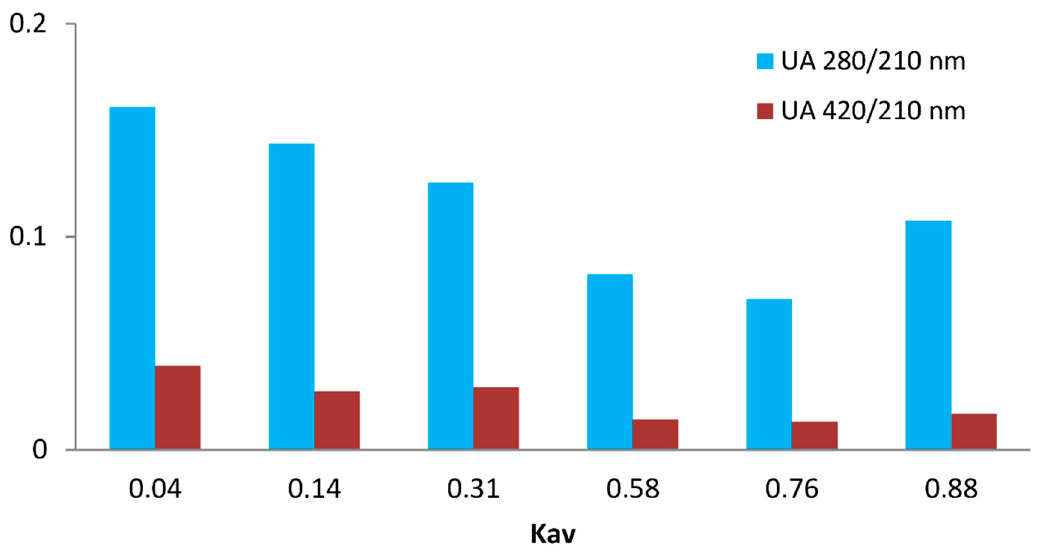
Figure 7. Bar diagram of the ratios of absorbances at λ 280 and λ 420 nm to absorbance at λ 210 nm for the fractions obtained by size-exclusion chromatography of IHS. Table 2. Elemental composition of melanoidins fractions from